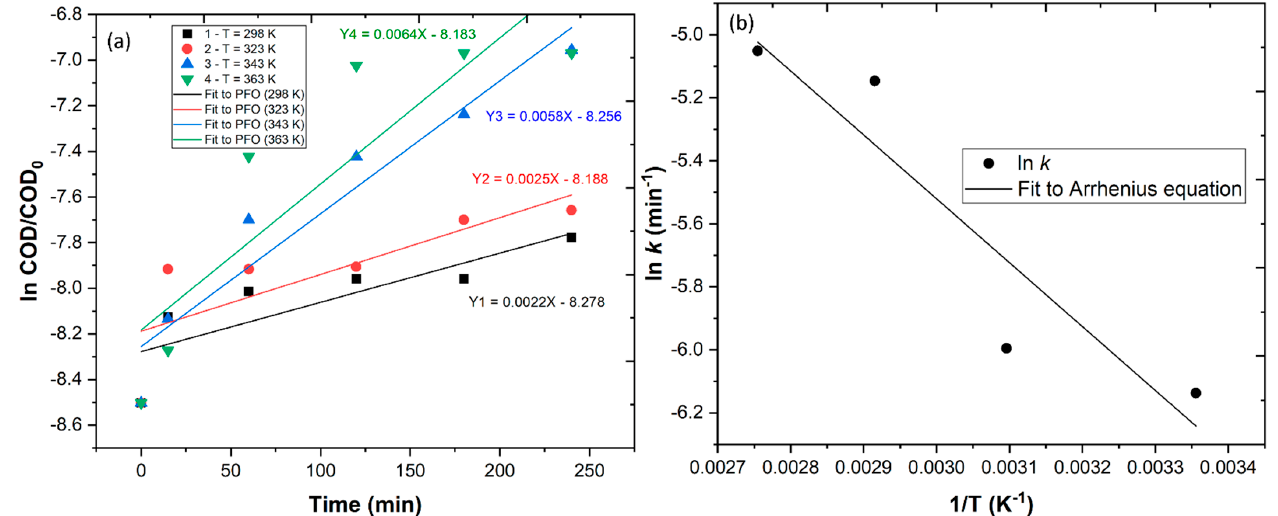
Figure 6. ( a ) Pseudo first-order of COD removal at different temperatures and ( b ) plot of ln k vs. 1/T for E a estimation using the Arrhenius equation.